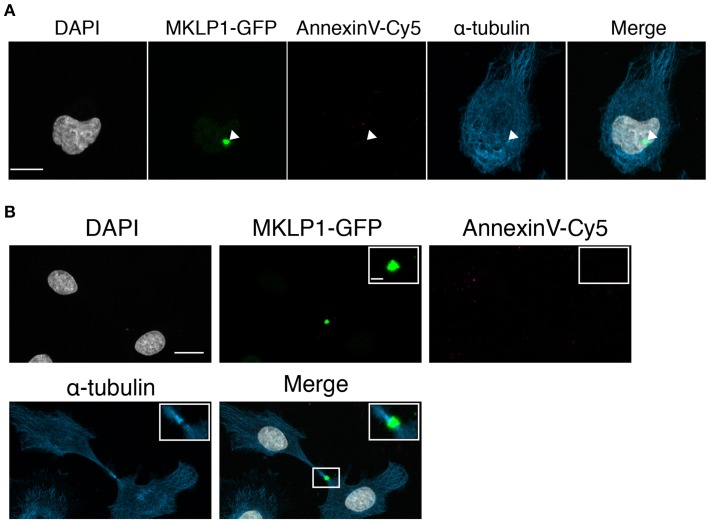
No AnnexinV-Cy5 colocalization with midbody markers in MKLP1-GFP HeLa cells. (A,B) MKLP1-GFP HeLa cells were incubated with AnnexinV-Cy5 for 10 min in culture medium. Images were obtained as z-stacks every 0.38-μm and are maximum intensity projections. Shown are individual channels and merge for MKLP1-GFP (green), AnnexinV-Cy5 (red), immunofluorescence for α-tubulin (blue), and DAPI staining (white). Scale bars, 10 μm. (A) Example for monolateral midbody. White arrow heads indicate the MKLP1-GFP positive midbody. (B) Example for bilateral midbody. Inset, magnification of boxed region in merged channel. Scale bar, 1 μm.